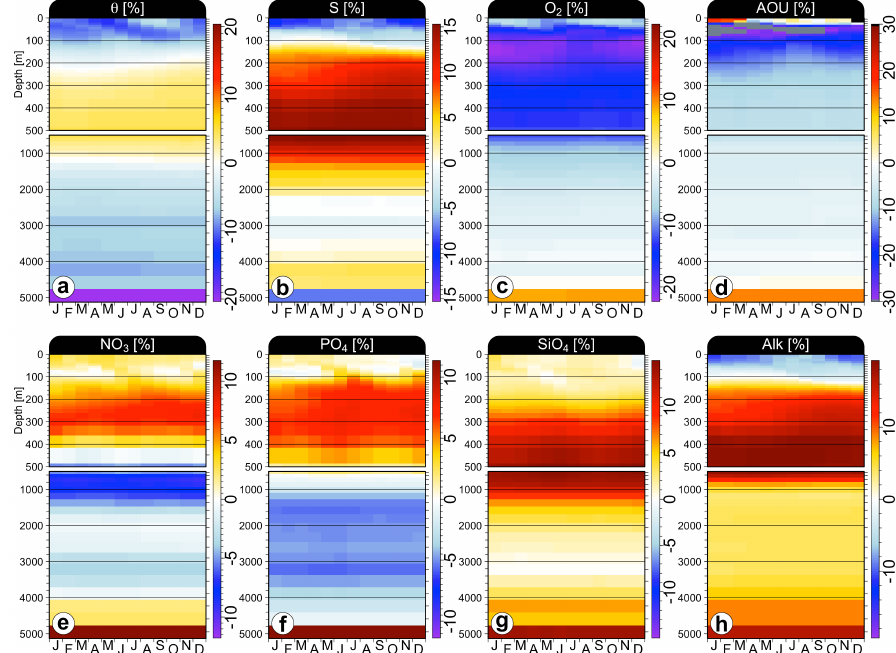
Fig. A2. Monthly vertical profile of the month-by-month relative changes of the horizontal spatial standard deviation, from January to December, expressed in percent relative to the 1995 values, between the synthetic 2005 CLIVAR dataset and the 1995 GLODAP dataset for the variables used in this study. Tick marks to the right of the main panels show the vertical position of the layers in the circulation